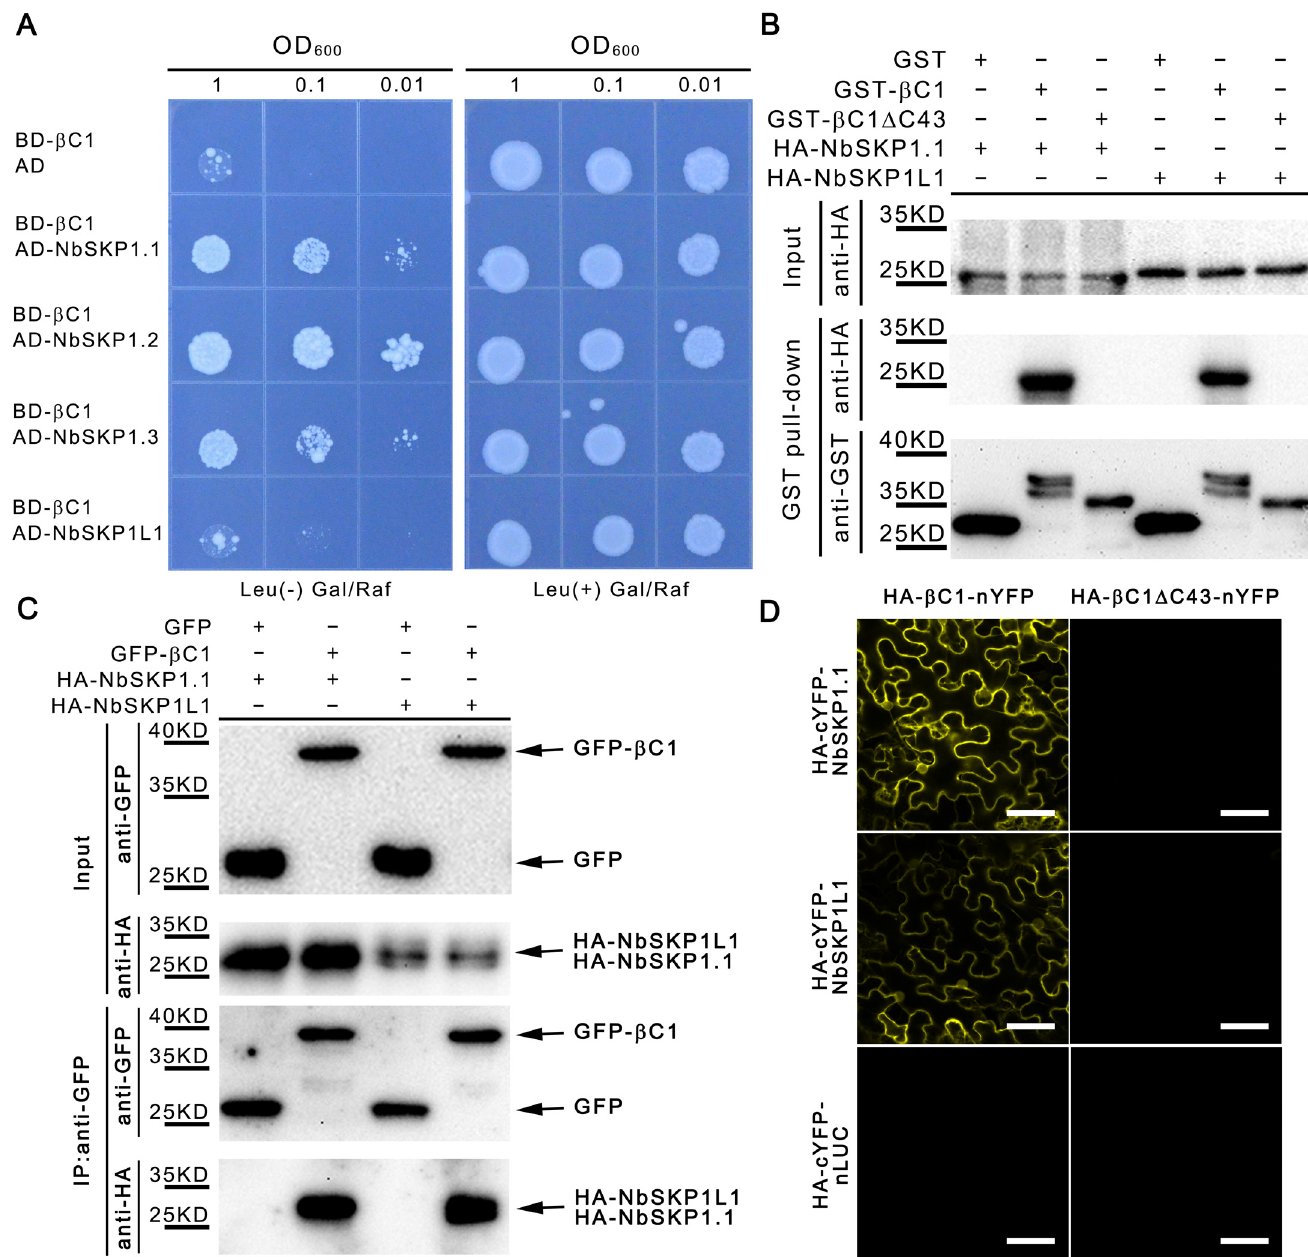
Fig 1. NbSKP1s interacts with CLCuMuB β C1 in vitro and in vivo . (A) Growth of SKY48 yeast strains containing NLS-LexA BD-CLCuMuB β C1 transformed with AD-NbSKP1s, AD-NbSKP1L1 or AD (control) on Leu-containing (Leu + ) and Leu-deficient (Leu − ) medium with galactose (Gal) and raffinose (Raf) at 28°C for 4 d. Yeast cells were plated at OD 600 = 1, 0.1, 0.01. (B) In vitro GST pull-down assays. His-HA-NbSKP1.1 and His- HA-NbSKP1L1 were pulled down by GST-CLCuMuB β C1 (GST- β C1), GST or GST- β C1 Δ C43. β C1 Δ C43 represents a β C1 mutation with the deletion of C-terminal 43 amino acids. GST beads were washed and proteins were analyzed via SDS-PAGE and western blot assays using anti-GST and anti- HA antibodies. (C) Co-immunoprecipitation (co-IP) assays show that CLCuMuB β C1 interacted with NbSKP1.1 and NbSKP1L1 in vivo . GFP-tagged CLCuMuB β C1 (GFP- β C1) was co-expressed with 2×HA-tagged NbSKP1.1 or NbSKP1L1 (HA-NbSKP1.1 or HA-NbSKP1L1) in N . benthamiana leaves by agroinfiltration. GFP co-expressed with HA-NbSKP1.1 or HA-NbSKP1L1 was introduced as a negative control. At 48 hpi, leaf lysates were immunoprecipitated (IP) with GFP-Trap agarose, then the immunopercipitates were detected by western blotting using anti-GFP and anti-HA antibodies. (D) A confocal image of BiFC shows a positive result in leaf epidermal cells. NbSKP1.1 or NbSKP1L1 fused with HA and the C-terminal fragment of YFP (HA-cYFP-NbSKP1.1 or HA-cYFP-NbSKP1L1) was transiently co-expressed in leaves of N . benthamiana with CLCuMuB β C1 or β C1 Δ C43 fused with HA and N-terminal fragment of YFP (HA- β C1-nYFP or HA- β C1 Δ C43-nYFP). Bar scale represents 40 μ m. Photos were imaged at 48 hpi using a Zeiss LSM 710 laser scanning microscope. nLUC represents the N-terminal fragment of firefly luciferase.